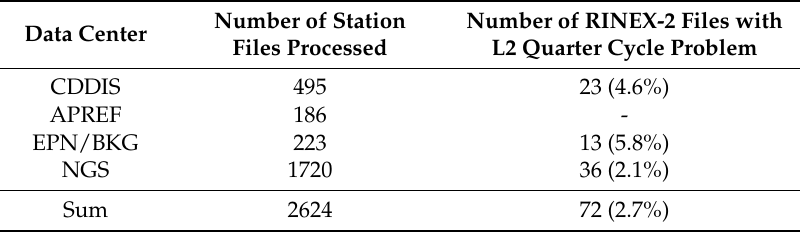
Table 3. Detection Results by Data